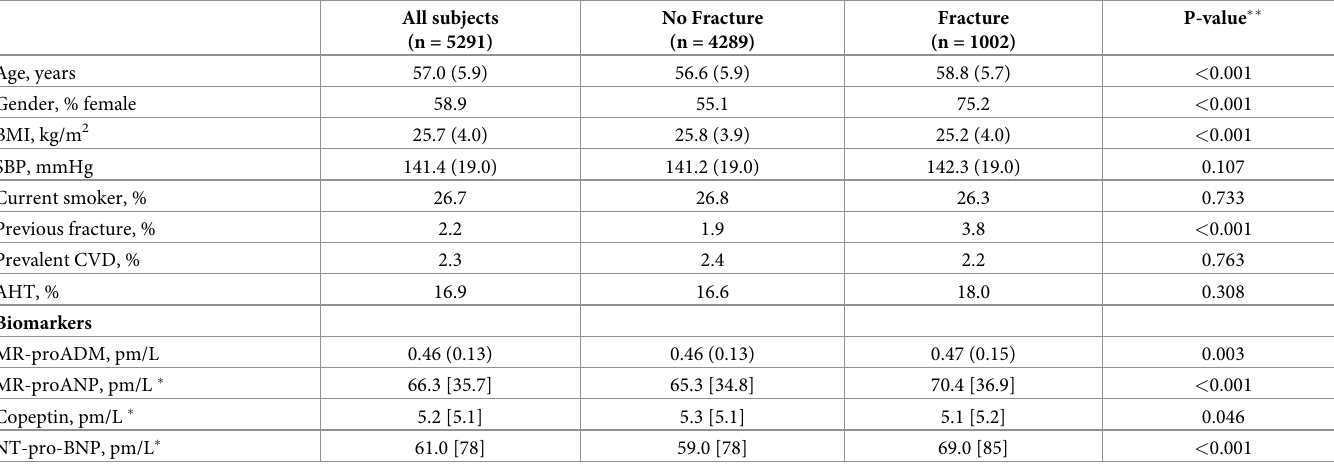
Table 2. Baseline characteristics of study population stratified by incident fracture during